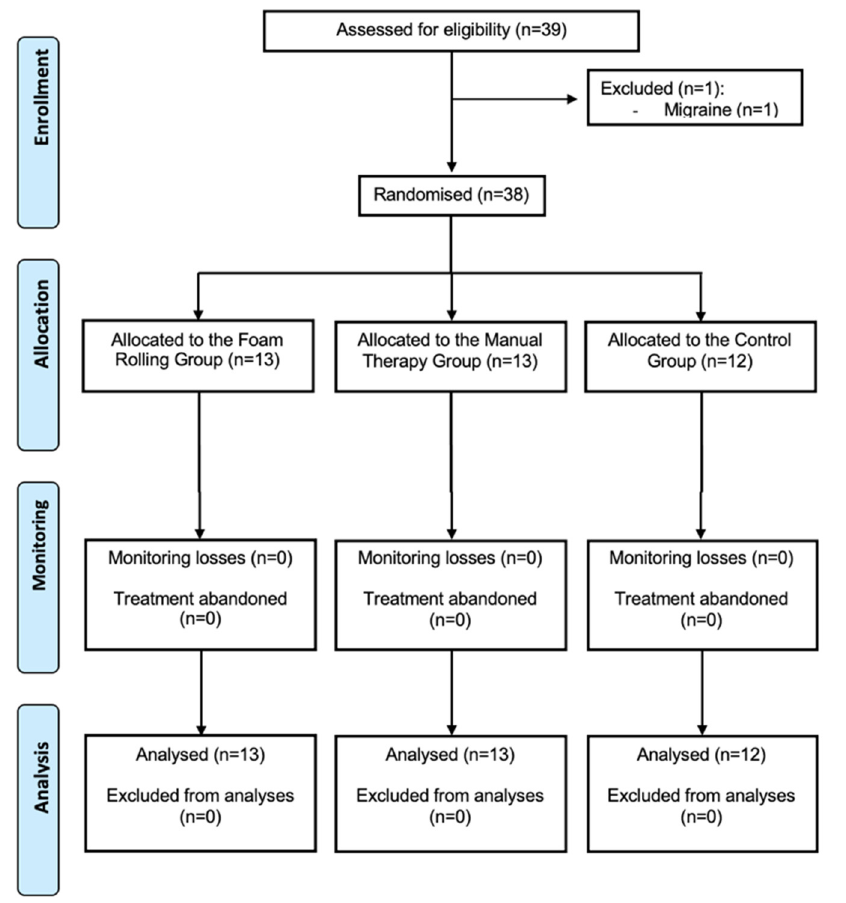
Figure 1. Flow chart according to CONSORT statement for the report of randomized trials. Table 2. Baseline comparisons of demographic and clinical